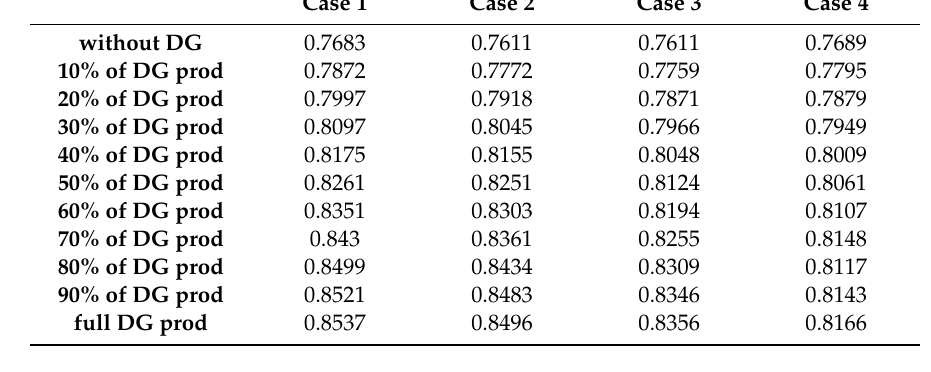
Table 5. Calculated value of the objective function. DG: distribution generation.